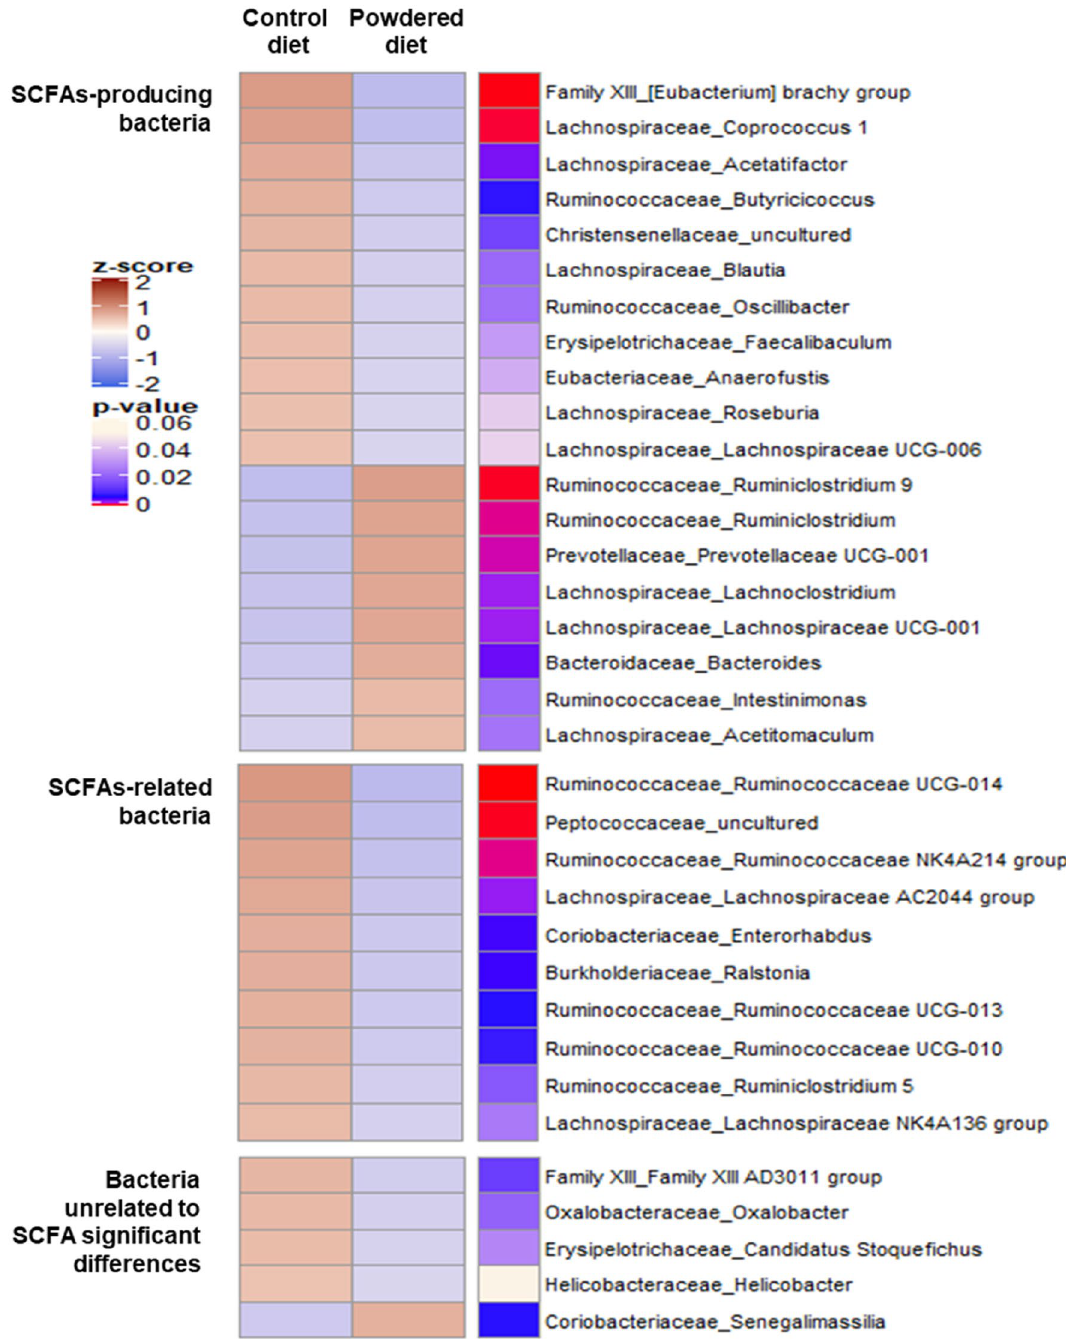
Figure 4. Heat map of relative abundance of taxa with significant differences at the genus level for SCFAs- producing bacteria, SCFAs-related bacteria (bacteria that grow on SCFAs, bacteria whose presences are directly proportional to the level of SCFAs, or close relatives of SCFA-producing bacteria), and bacteria unrelated to SCFAs, in the cecal microbiota compositions comparing long-term powdered diet-fed mice and control diet-fed mice (mean relative abundance > 0.1%). The abundance of each genus is plotted in a brown–blue color scale. The brown and blue colors indicate high and low abundance, respectively. n = 8 per